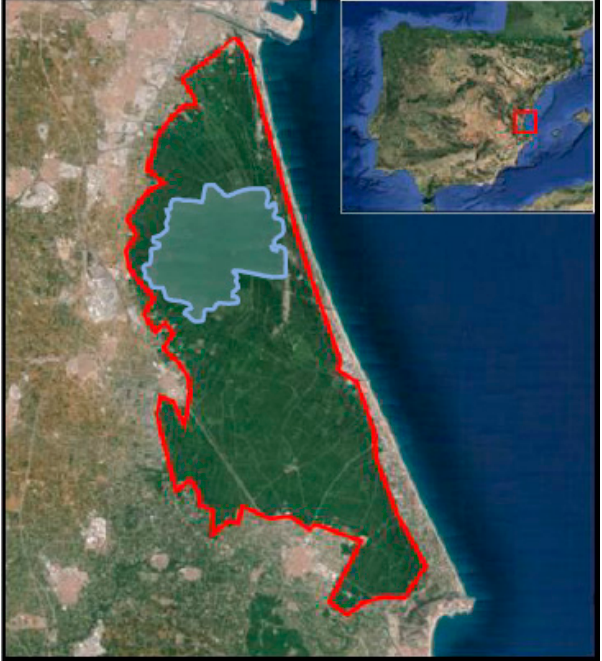
Figure 6. Albufera Natural Park (2012) orthophoto with the delimitation of rice field area and lagoon. Outside the validation mask, rice pixels were classified in the first category (green), with both indices while pixels corresponding to other crops and natural areas were classi- fied in the second and third categories (yellow and orange, Figure